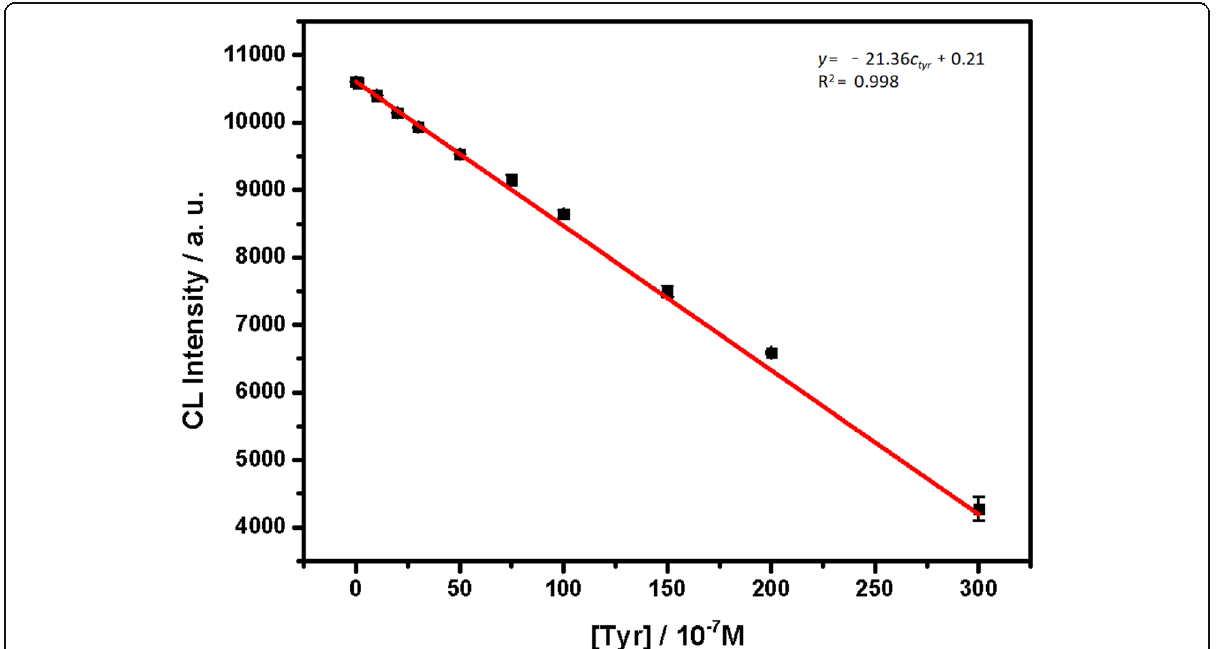
Fig. 4 Calibration curve of Tyr. Experimental conditions: c (BR) = 0.0018 mmol/L at pH 7.8, c (ABEI) = 0.037 mmol/L, c (sodium fluorescein)= 0.701 mmol/L, c (H 2 O 2 ) = 0.014 mol/L, c (HRP) = 0.098